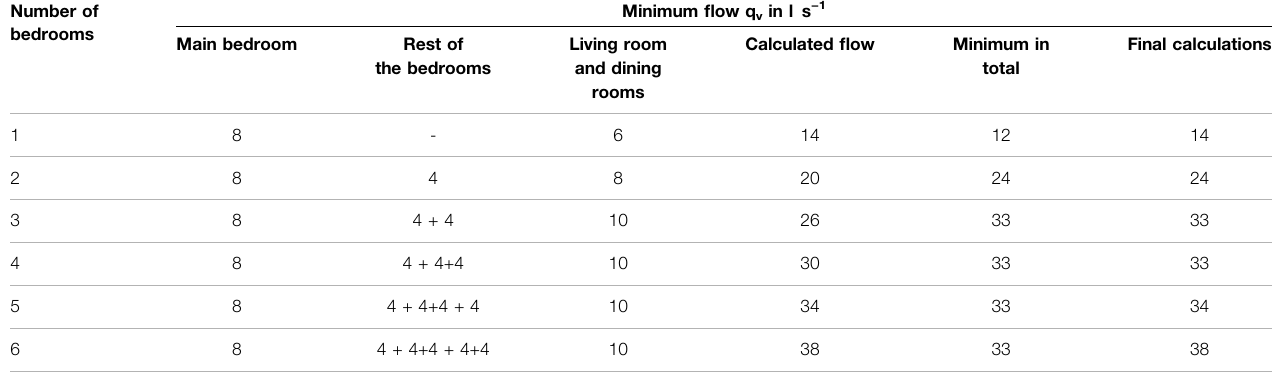
TABLE 7 | Calculation of ventilation according to Spanish regulations (CTE DB HS). Number of bedrooms